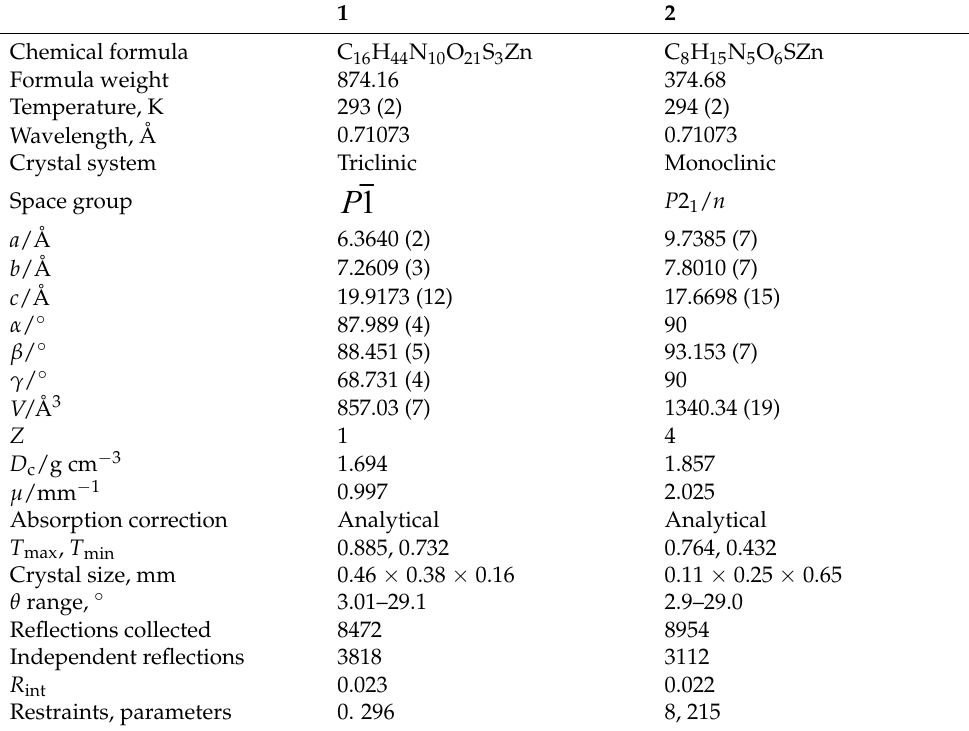
Table 4. Crystal data and refinement parameters for the complexes.